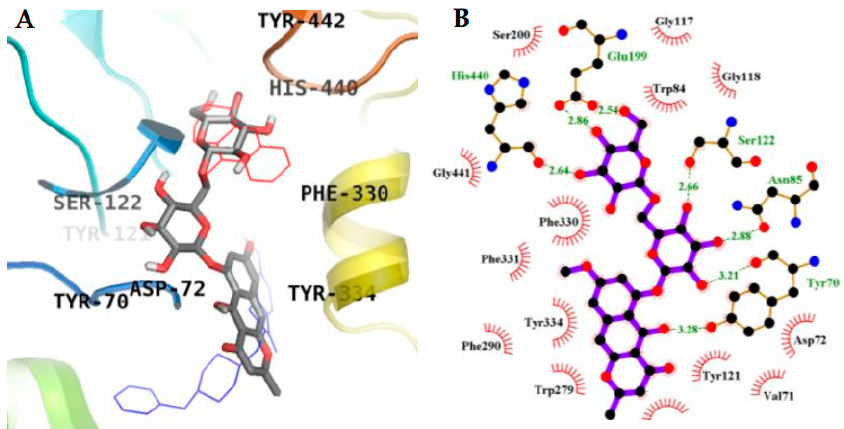
Figure 5. Inhibition mode of 3 ( A ) for the AChE active site with tacrine (red line) and donepezil (blue line) ( A ); 2D ligand interaction diagram of AChE mixed inhibition by 3 ( B ). Dashed green lines indicate H-bonds. Carbons are in black, nitrogens in blue, and oxygens in red.